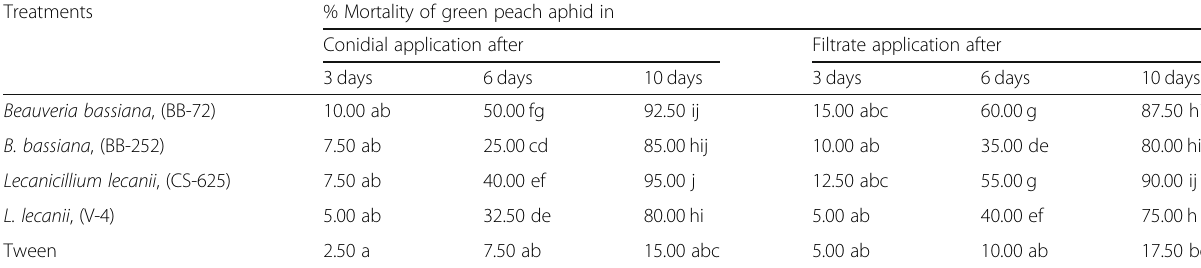
Table 2 Mortality of green peach aphid in conidial and filtrate applications Treatments % Mortality of green peach aphid in Conidial application after